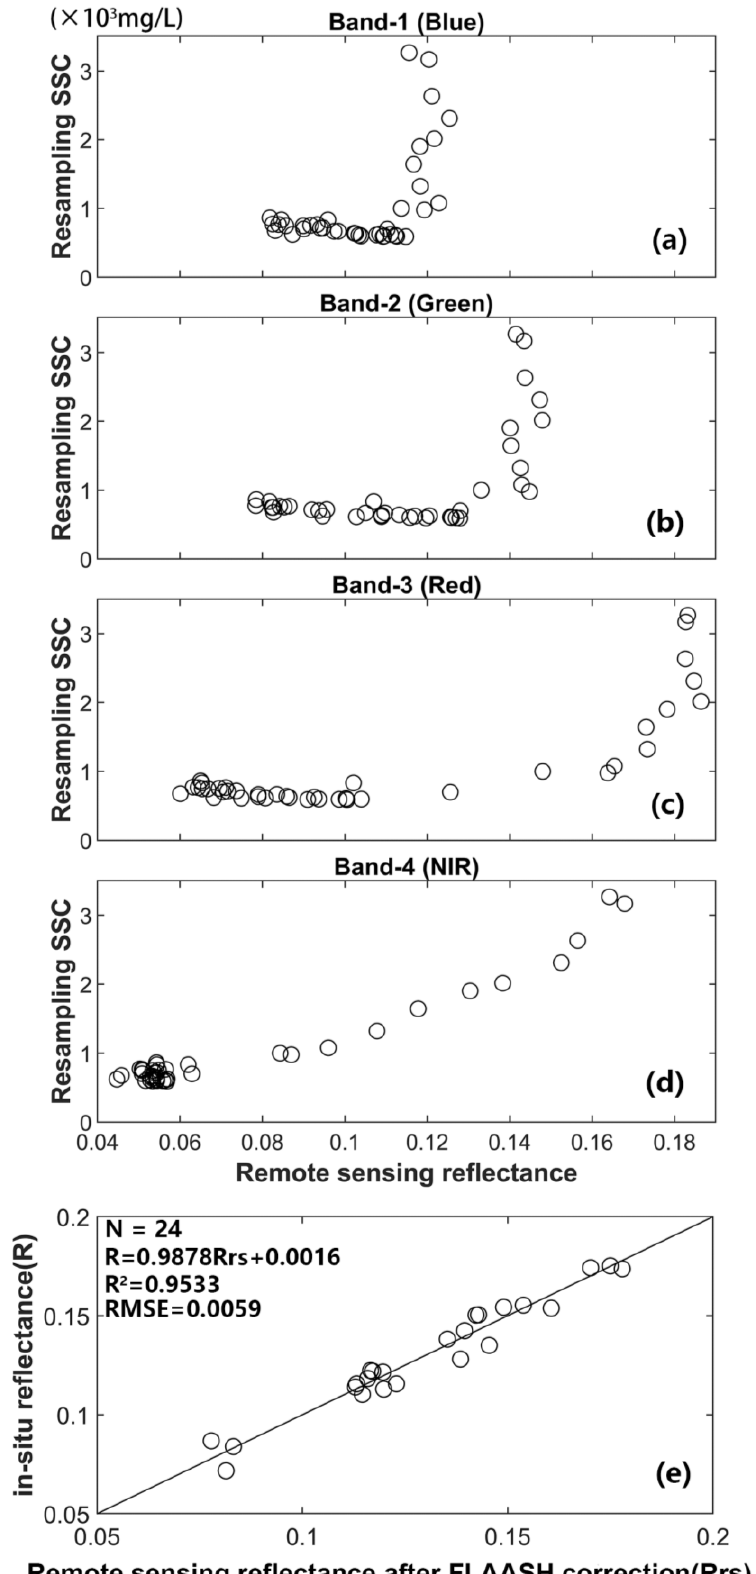
Figure 2. Profile of the SSC and the remote sensing reflectance (after atmospheric correction) of each single band ( a – d ). The linear fitting plot of the in-situ reflectance and the remote sensing reflectance after atmospheric correction based on the FLAASH model ( e ).